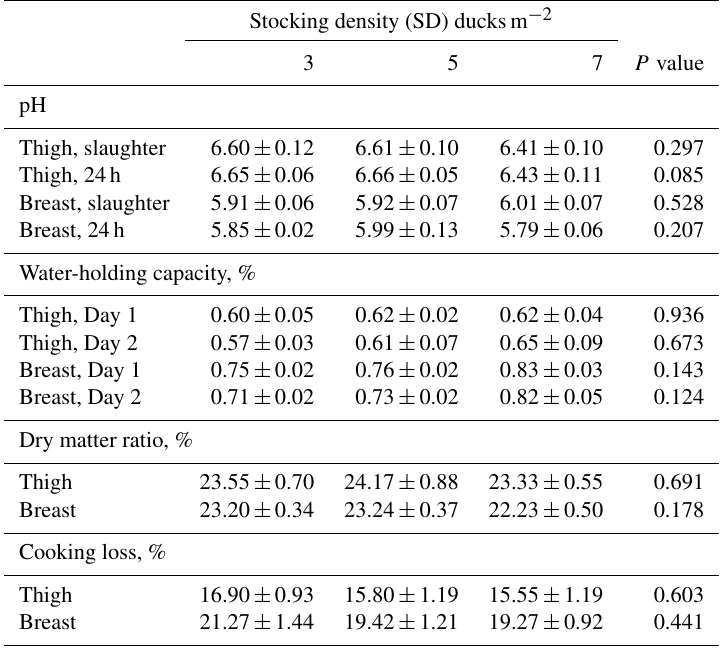
Table 3. The effects of stocking density on the meat quality of Pekin ducks (mean ±